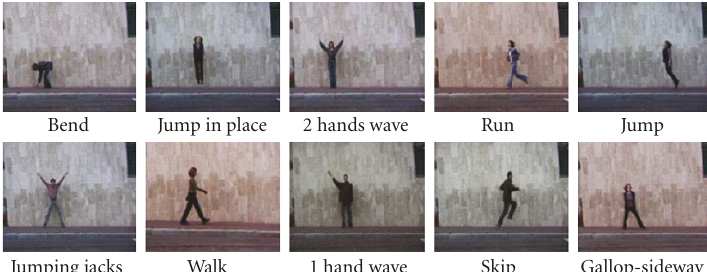
Figure 6: Example images from video sequences in Weismann dataset. We benchmarked on this dataset with the unsupervised method in the current